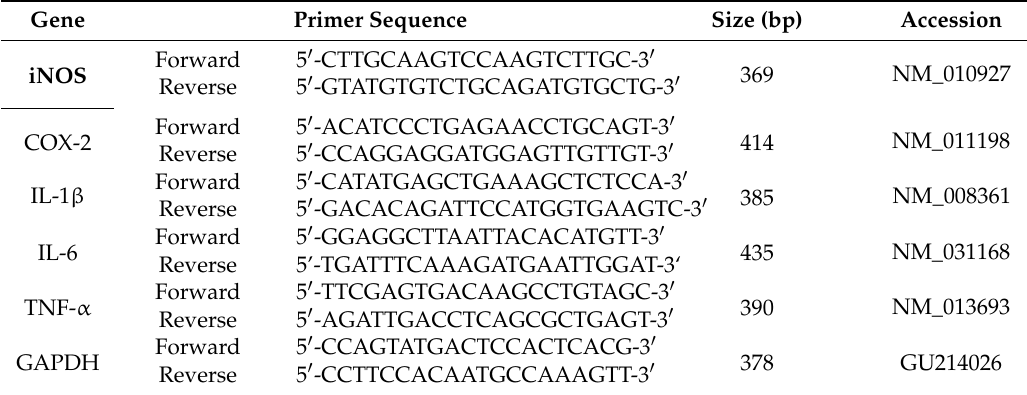
Table 2. Primer sets used for